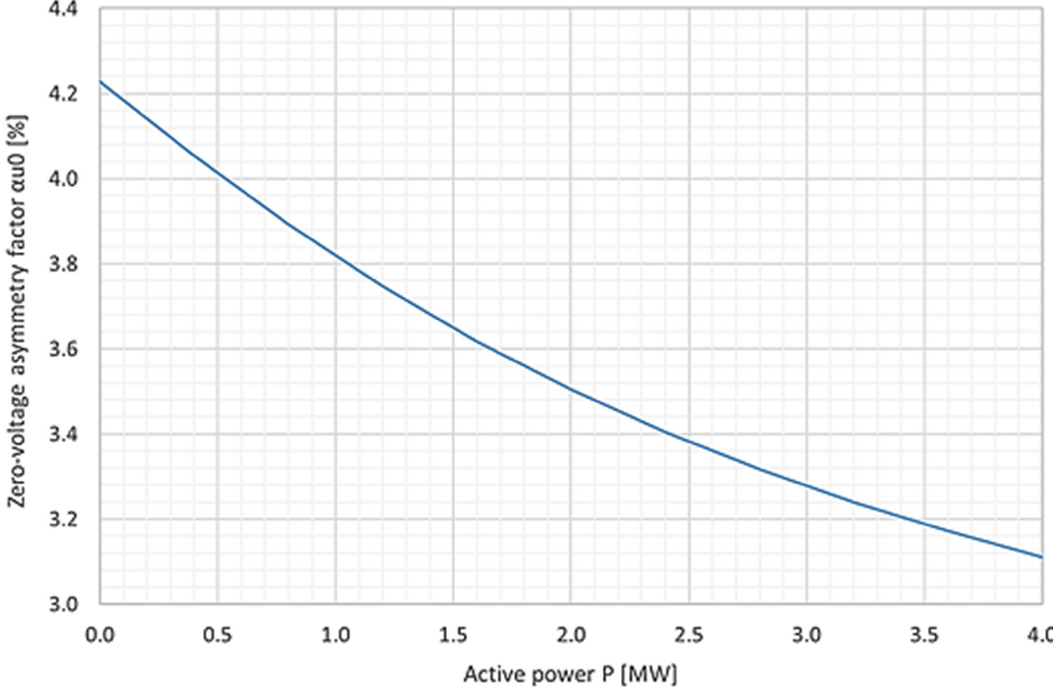
Figure 7. Dependence diagram of the zero-voltage asymmetry factor ( α u0% ) on the active power of the load (P), determined by the analytical method.